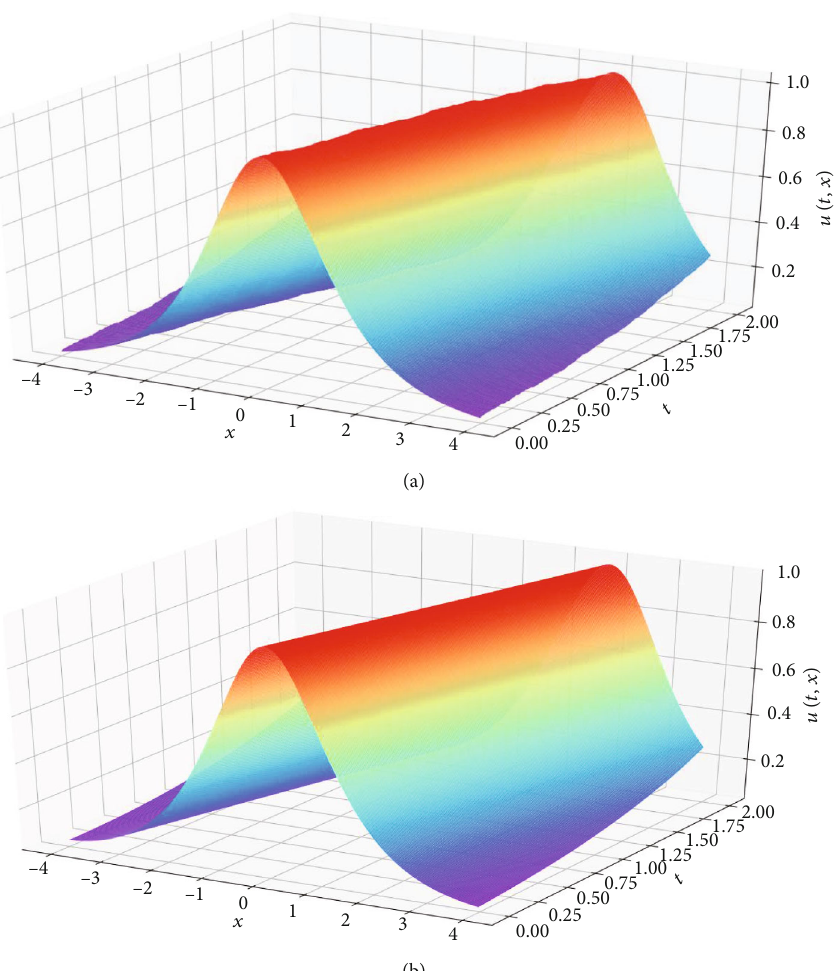
Figure 1: The three-dimensional diagram of the exact solutions (a) and predicted solutions (b) of the mkdv equation with initial state u ð x , 0 Þ = 2 exp ð − x Þ / ð exp ð − 2 x Þ + 1 Þ